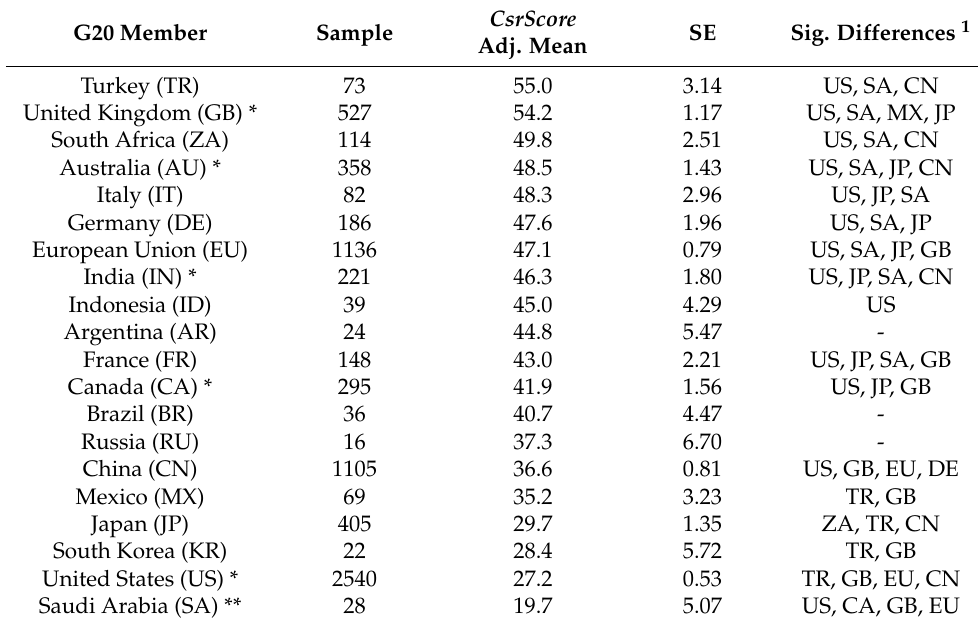
Table 4. The analysis of covariance of CsrScore by country/group of countries, adjusted for company size, in descending order. G20 Member Sample